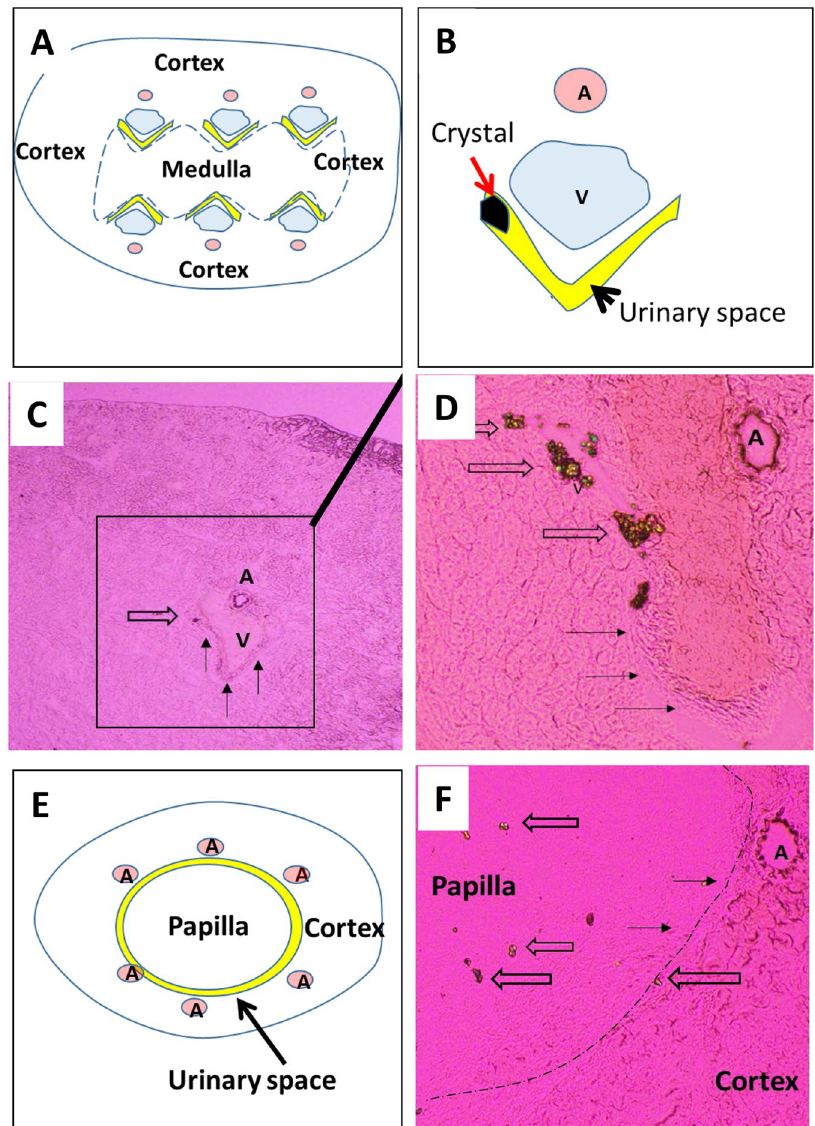
Figure 1. ( A ) Schema representing a kidney sagittal section with urinary spaces corresponding to specialized fornices area per section. ( B ) Magnification of one specialized fornix showing a crystal attached to urothelial cells and close to interlobar arteries and veins (A and V respectively) representing figure ( C ) features. ( C ) Crystal deposit within one renal specialized fornix in the HLP group on days 15 and 42. ( D ) (urinary spaces are indicated by arrows). ( E ) Schema representing a papilla sagittal section and ( F ) Crystals (large arrows) along the urothelium (thin arrow) and within papilla. Frozen sections. Original magnification: ( C ) x40. ( D , F ) x100. A = artery. V =